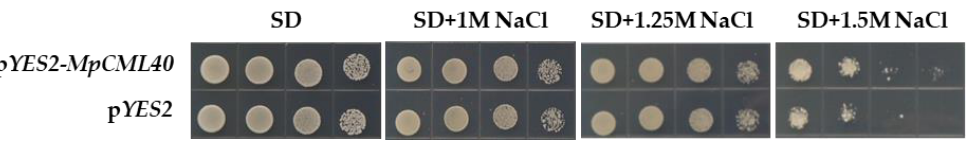
Figure 4. Gene expression changes of MpCML40 in Pongamia roots and leaves upon salt stress. Relative expression levels of the MpCML40 gene in roots ( A ) and leaves ( B ) after 500 mM NaCl treatment were analyzed by qRT-PCR using primers listed in Table 2. MpActin gene was used as an internal reference. Error bars show mean values ( ± SD) of three independent samples. *** p < 0.001 (Student’s t -test).